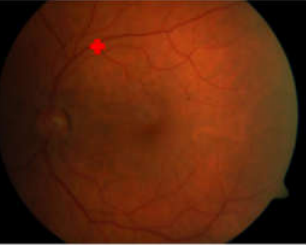
Figure 10. Macular center detection failure on image059.png of DiaretDB1.